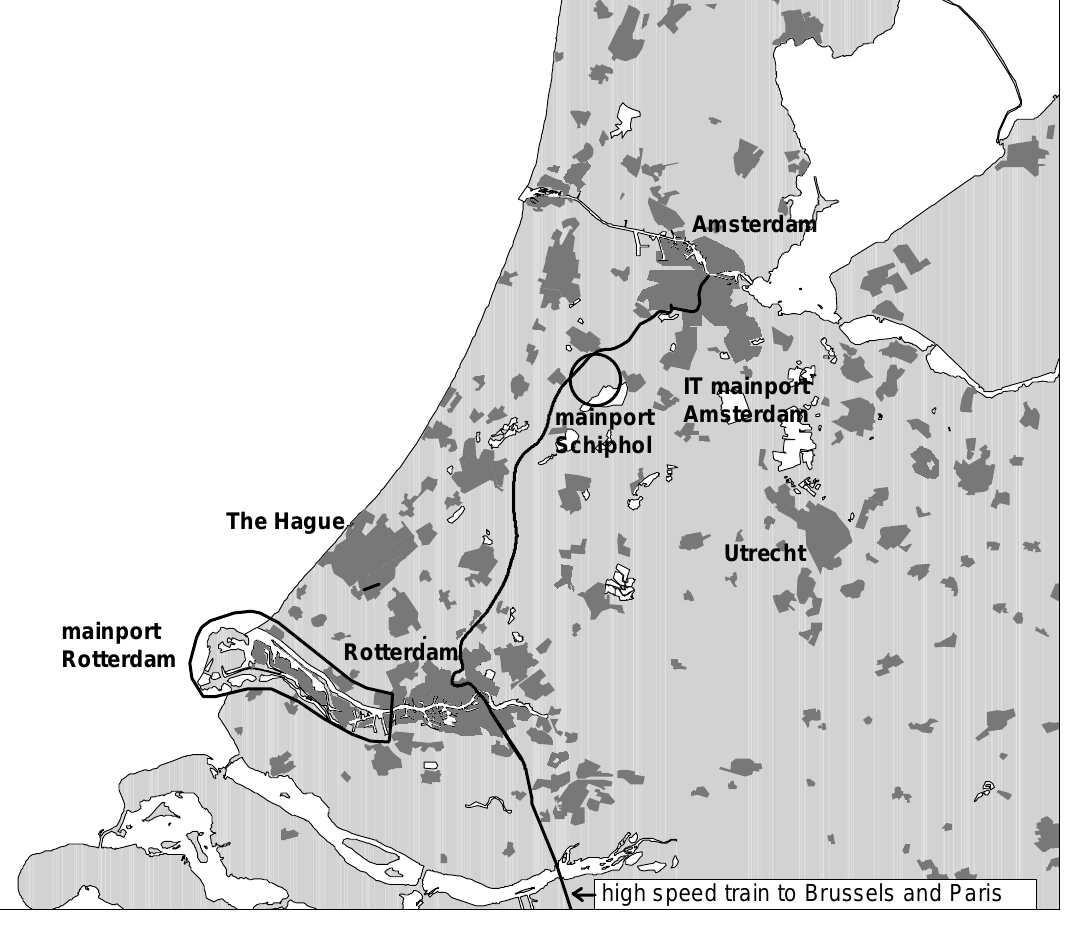
Figure 5. Mainport functions of Randstad Deltametropolis The Netherlands mainports are links where flows of freight, passengers and information come together. The harbour of Rotterdam and airport of Amsterdam Schiphol connect the Dutch clusters with international